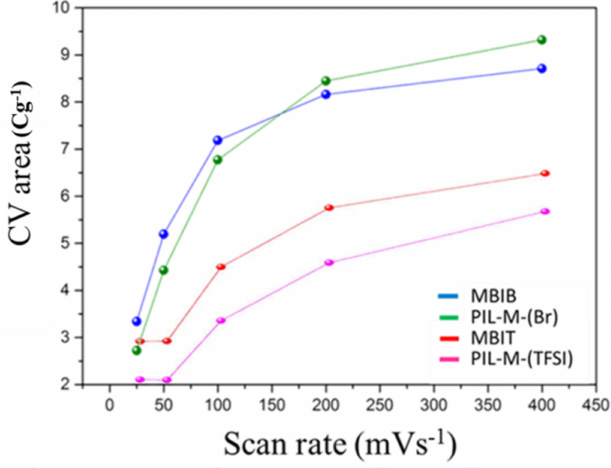
Figure 6. Plot of CV enclosed area against scan rate for ILs and PIL-IL blends.